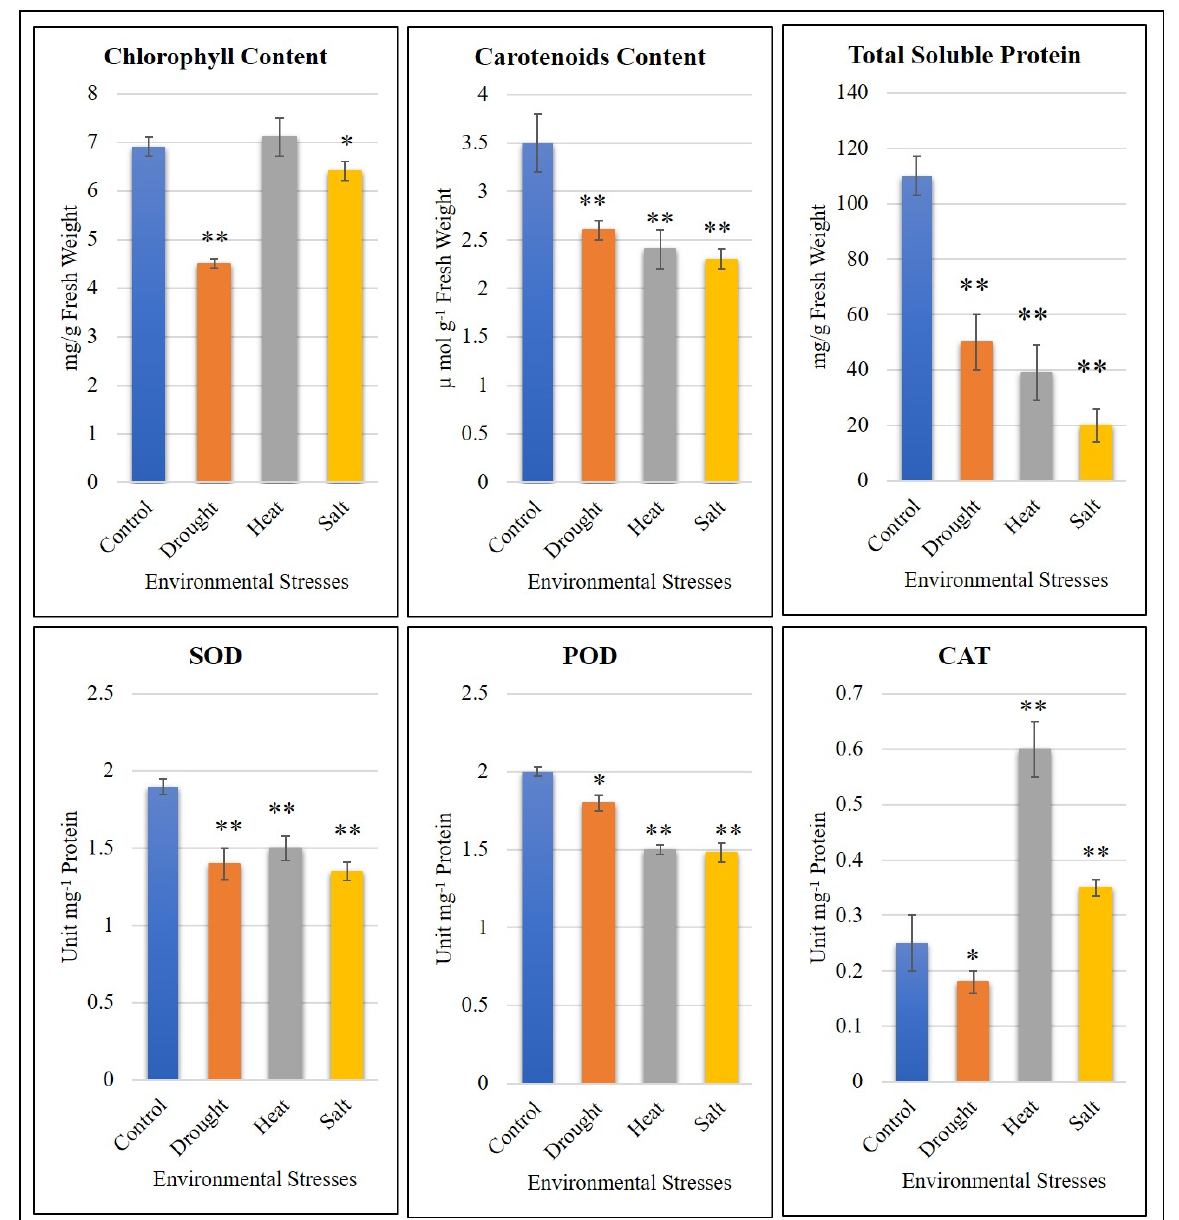
Figure 4. Effect of salinity, drought, and heat stress on carotenoids, chlorophyll, total soluble protein concentration, catalase activity (CAT), peroxidase activity (POD), and superoxide activity (SOD). One unit of enzyme activity represents the amount of enzyme that breaks down 1 µmol of H 2 O 2 /min under the assay conditions. The asterisk sign indicates significant changes compared to control, salt, heat, and drought stress (* p < 0.05, ** p < 0.01).